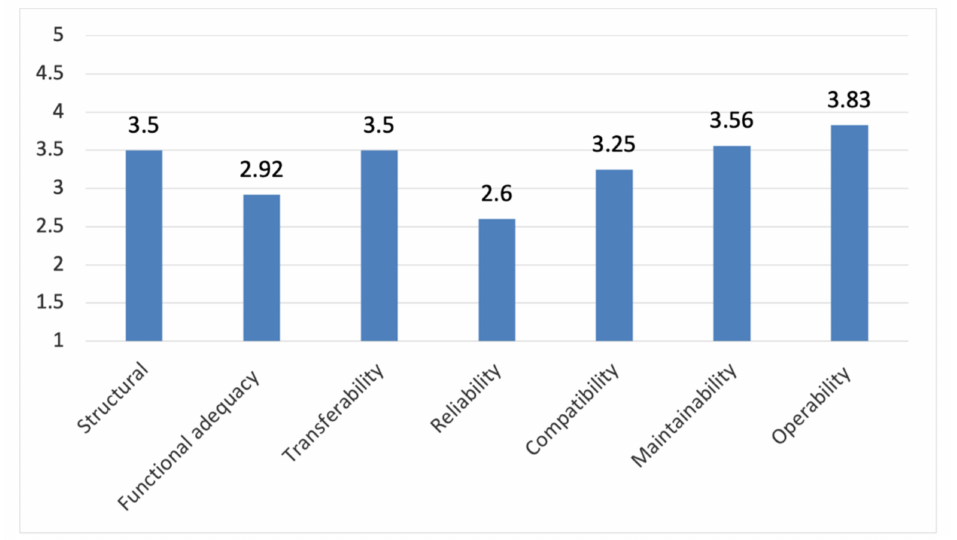
Figure 1. Quality of the CIDOC CRM according to the original OQuaRE evaluation